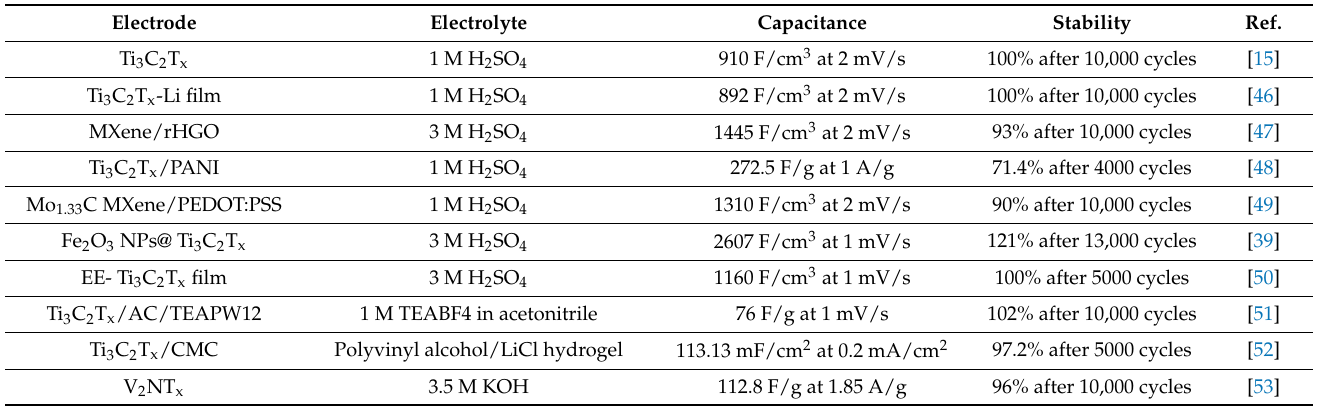
Table 2. Summary of electrochemical performance of MXene-based materials in